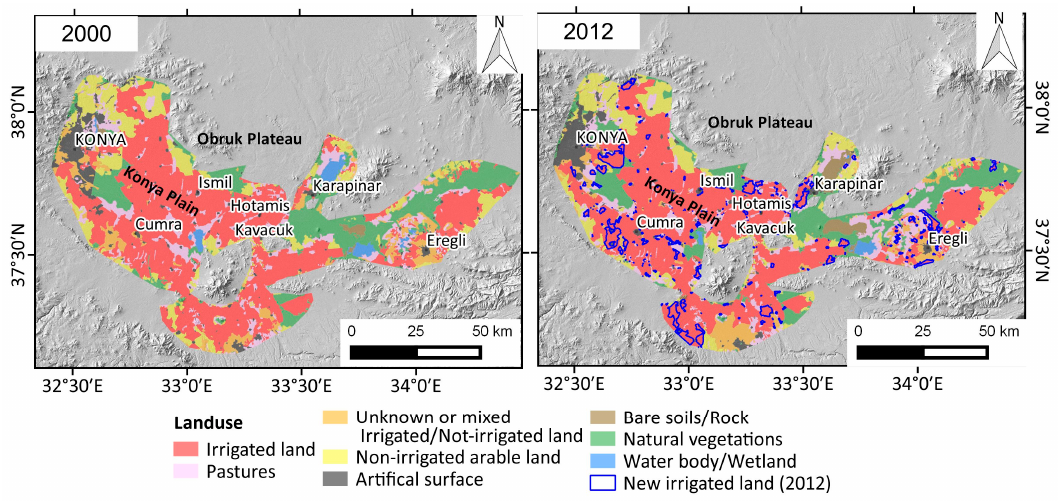
Figure 6. CORINE Land Cover simplified maps of the Konya plain for years 2000 and 2012. Blue polygons in 2012 map show areas changed from non-irrigated to irrigated.